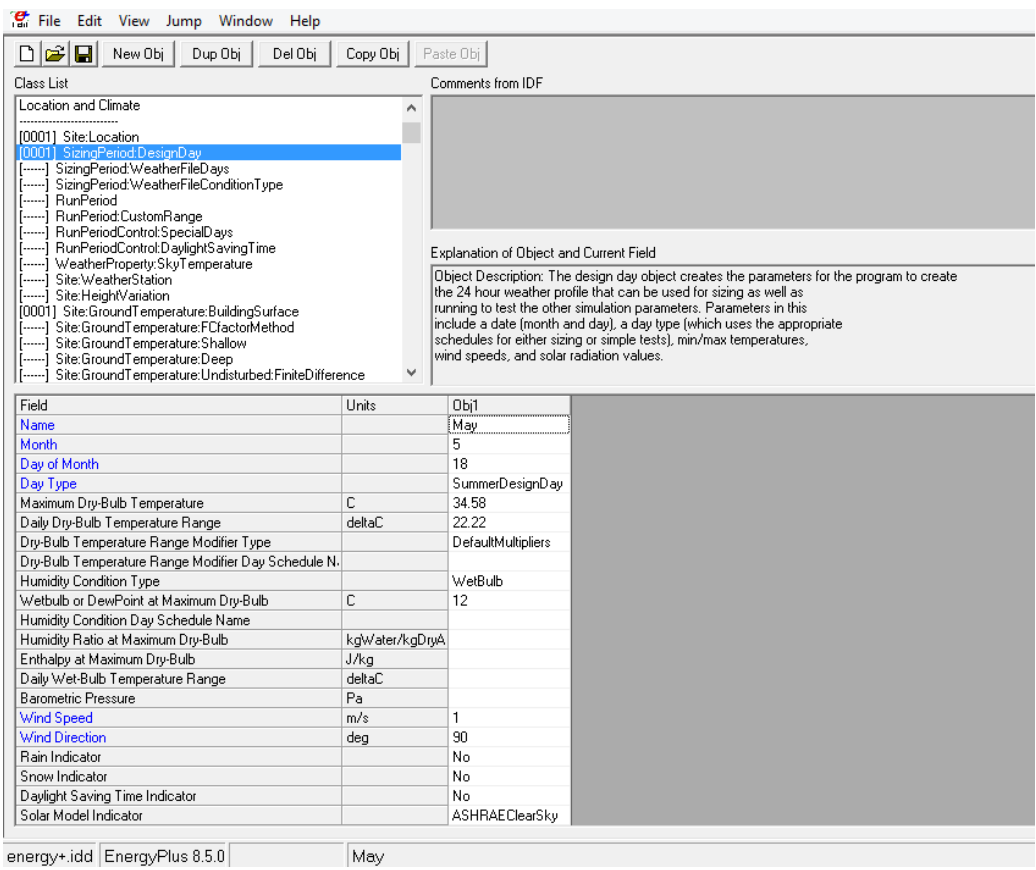
Figure 12. Function of EnergyPlus to overwrite the daily outdoor conditions considering the urban heat island (UHI) effect and its variations.